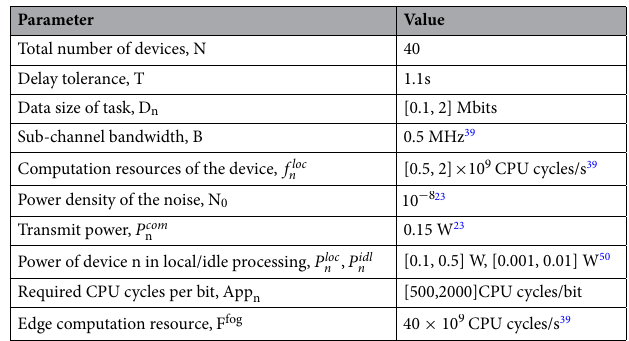
Table 3. Simulation